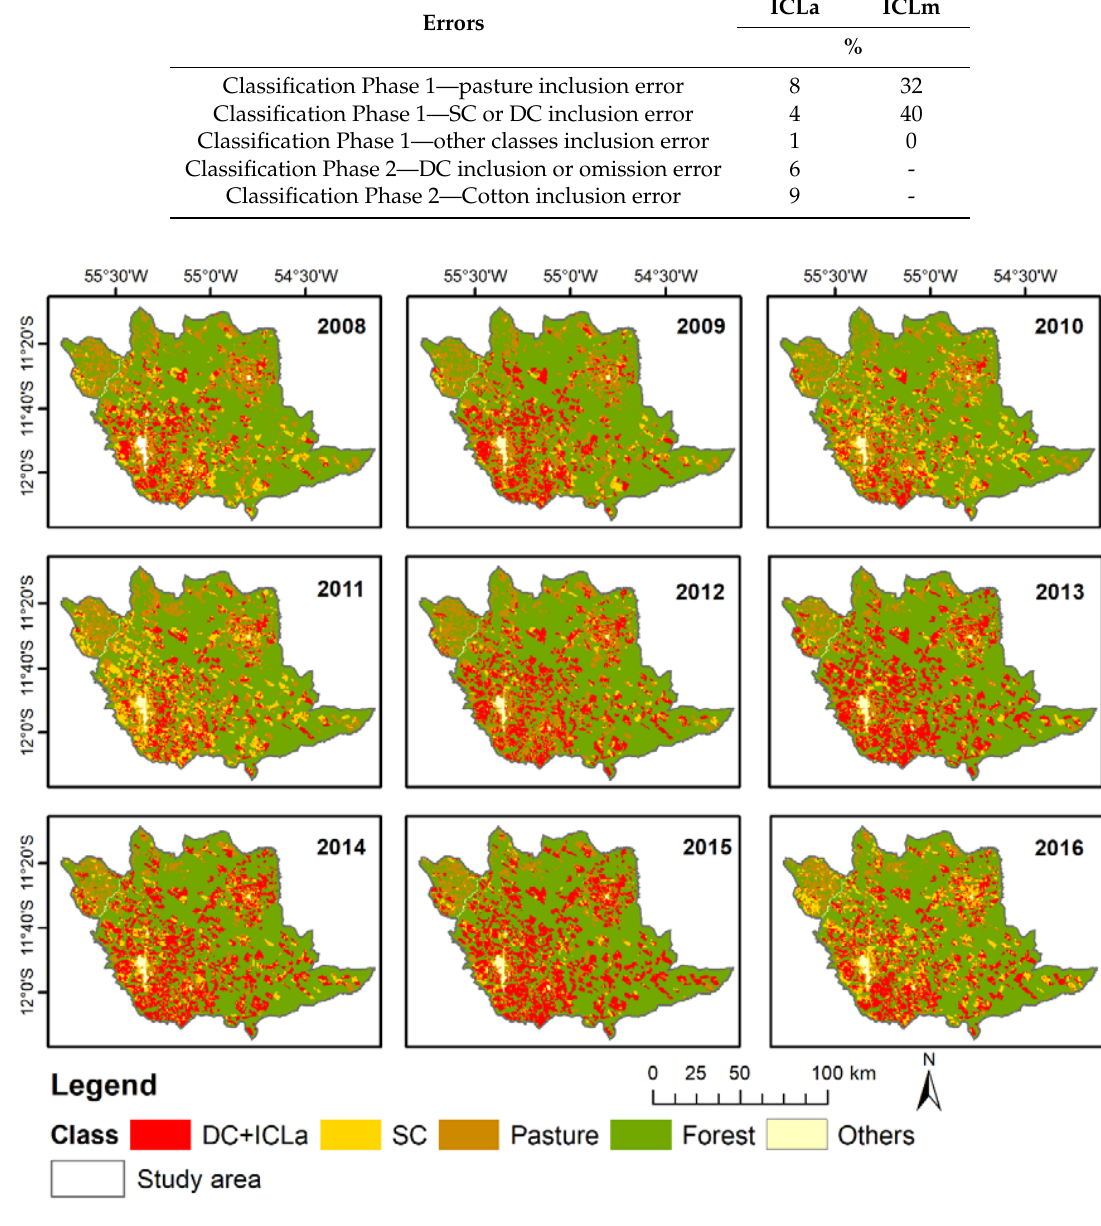
Figure 7. Phase 1 classification for the years